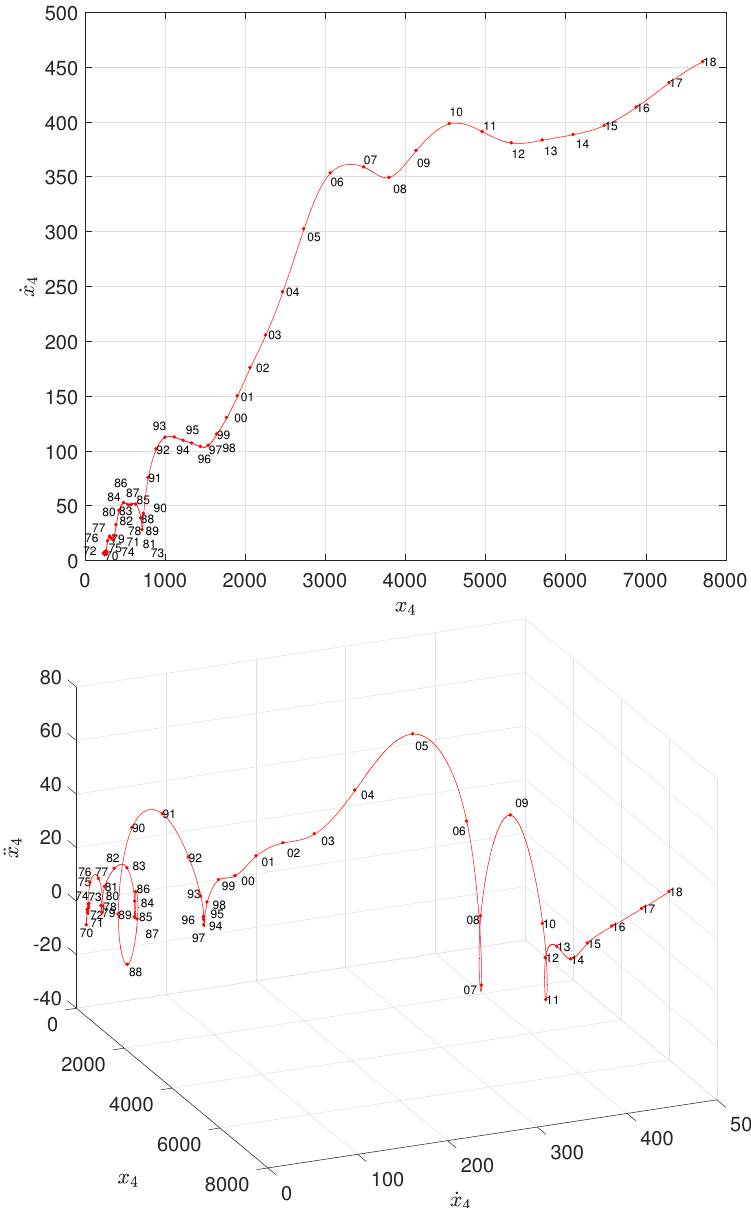
Figure 2. The 2- and 3-dim PS of China during